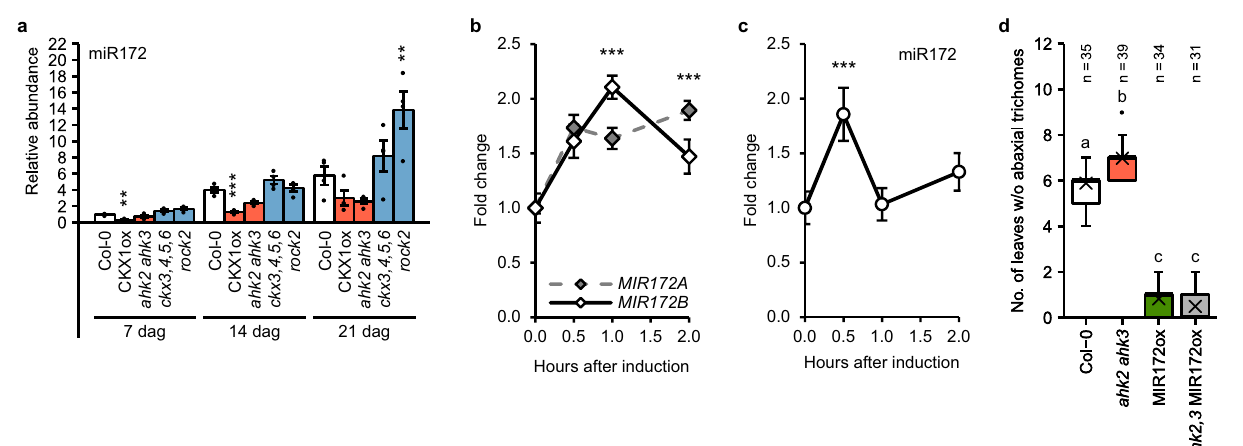
Fig. 5 Cytokinin increases miR172 abundance. a miR172 abundance in whole shoots of genotypes with an altered CK status compared to the wild type ( n = 4 biological replicates). See also Supplementary Fig. 7a. Dots indicate each single biological replicate. b , c miR172 and MIR172 gene expression kinetics in 10-day-old SD-grown wild-type seedlings after treatment with 1 µ M BA ( n = 6 biological replicates). Transcript levels were determined by qRT-PCR. Data were normalized to TAFII15 ( a , c ) or TAFII15 and PP2AA2 ( b ). Data displayed are expressed as mean ± SEM. Asterisks indicate signi fi cant differences compared to the wild type of the respective time point ( a ) or compared to time point 0 ( b , c ), as calculated by one-way ANOVA, post-hoc Dunnett ’ s test (* p < 0.05; ** p < 0.01; *** p < 0.001). d Number of leaves without abaxial trichomes in ahk2-5 ahk3-7 MIR172ox hybrid plants grown in SD. T1 plants shown in Supplementary Fig. 9 were used for the analysis. In box plots, the center line represents the median value and the boundaries indicate the 25th percentile (upper) and the 75th percentile (lower). The X marks the mean value. Whiskers extend to the largest and smallest value, excluding outliers which are shown as dots. Letters indicate signi fi cant differences between the genotypes, as calculated by Kruskal – Wallis test ( q < 0.05). Exact p -values and q -values calculated for a – d are included in the Source Data fi